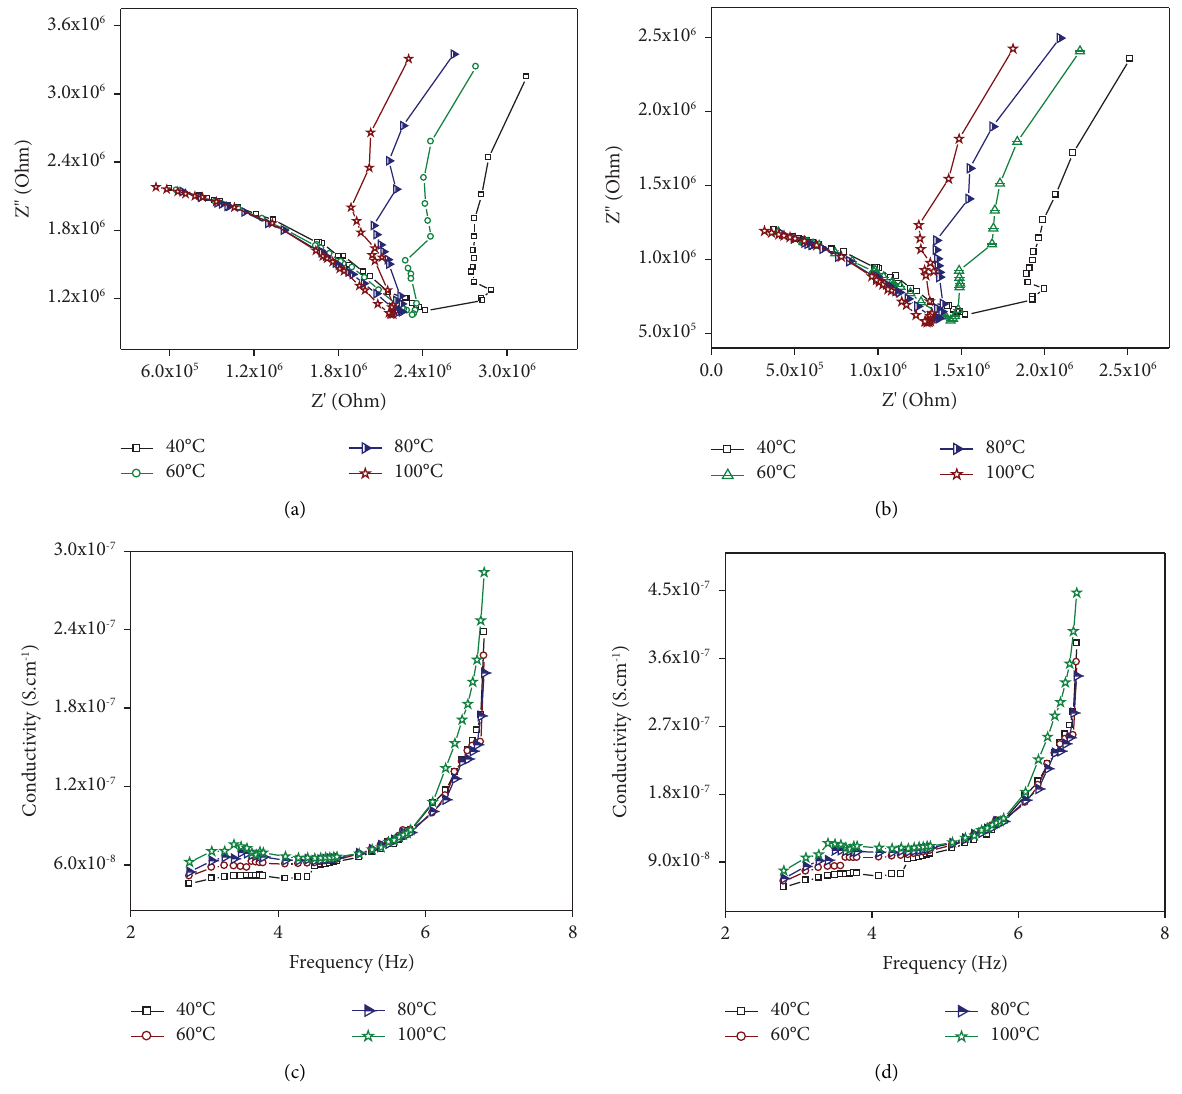
Figure 7: (a, b) Nyquist plots of LM and LS and (c, d) conductance spectra of LM and LS.